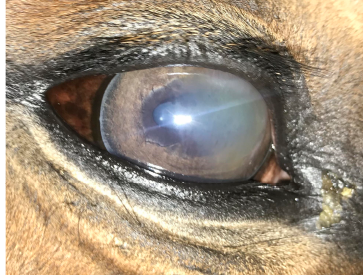
Figure 4. Diminish of blepharospasm and ocular discharge in case of a 6-year-old gelding of Polish Halfbred Horse.